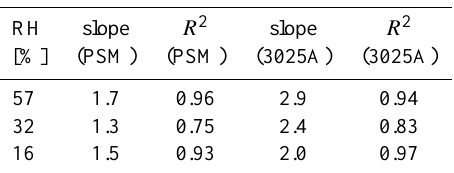
Table 3. The slopes ( d lnJ/ d ln [H 2 SO 4 ]) of fits to data in Fig. 1. at three different relative humidities (57, 32 and 16 %), and nucleation temperature 25 ◦